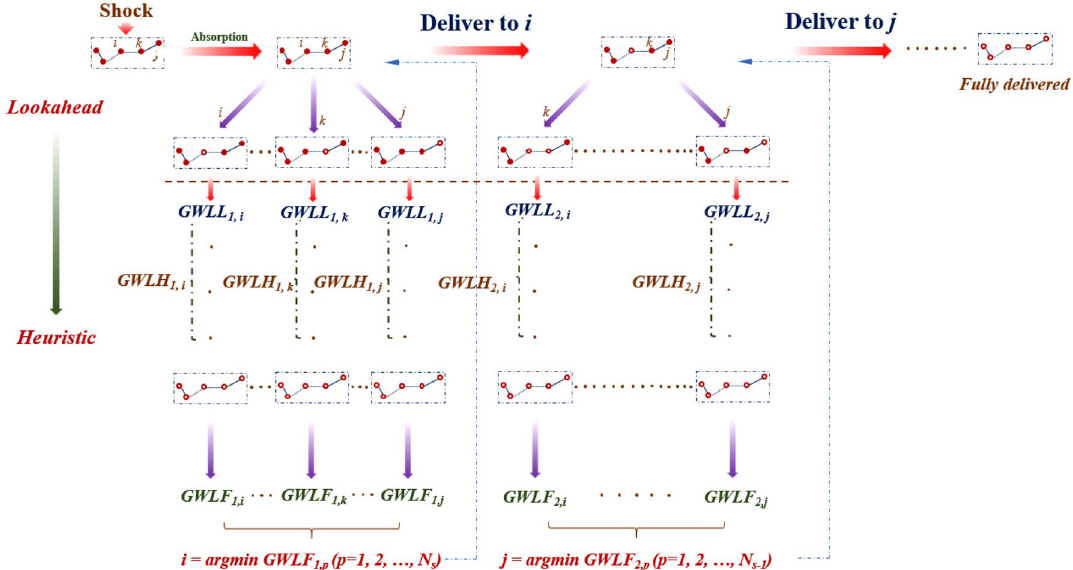
Figure 6. Lookahead-based strategy incorporating lookahead search and the heuristic. This figure illustrates how the lookahead searches can be run recursively, at each decision-moment, throughout the whole rapid response campaign. Essentially, driven by the combined outcome associated with the one-step lookahead, and the rollout of the succeeding heuristic, such a strategy is able to serve as the “move recommender” for the